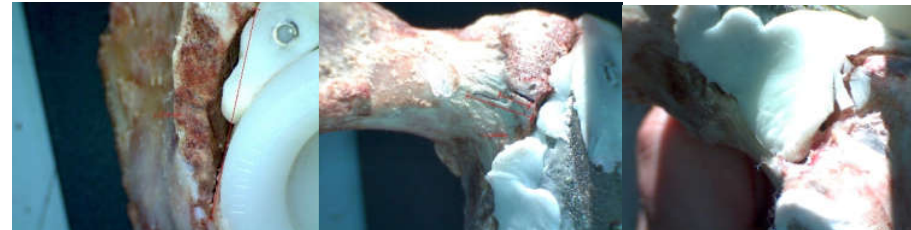
Figure 19. Stereomicroscope images and measurements.